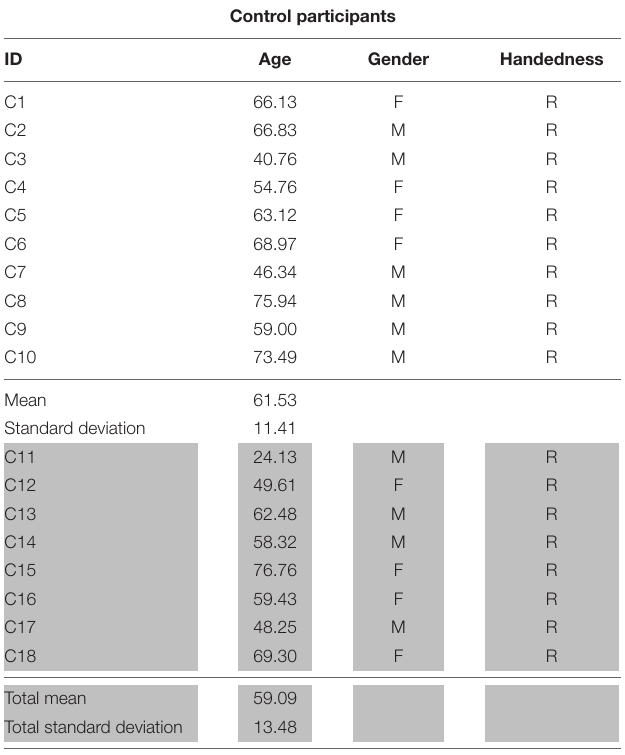
TABLE 1B | Demographic information for control participants including age, gender, and handedness. Control participants